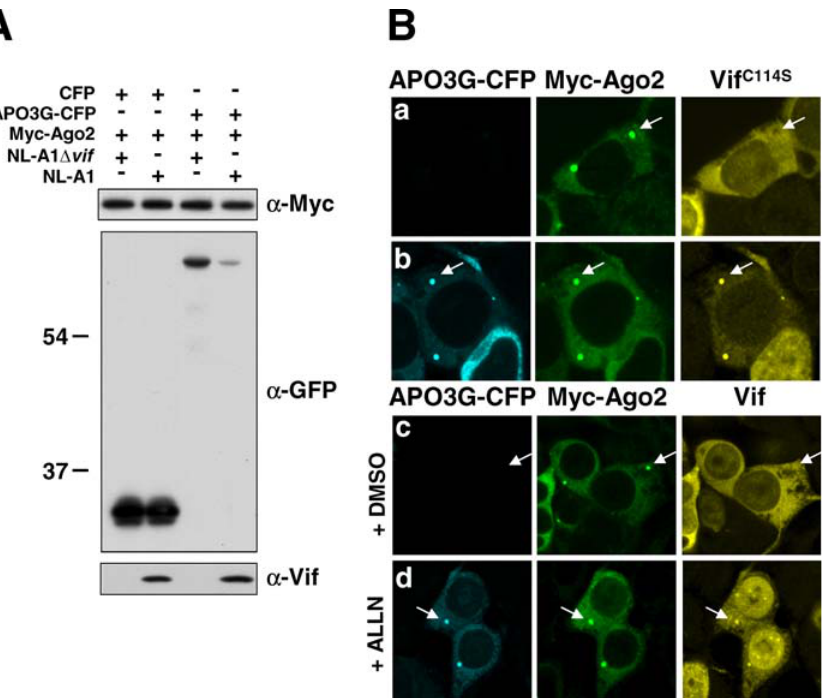
Figure 5. Localization of Vif to P-Bodies Requires APOBEC3G (A) Myc-AGO2 is not sensitive to Vif-mediated degradation in the absence or presence of APO3G-CFP. Total cell extracts from 293T cells expressing CFP or APO3G-CFP with Myc-AGO2 and either NL-A1 D vif or NL-A1 were analyzed by immunoblot with antibodies against CFP ( a -GFP), c-Myc ( a -Myc) and Vif ( a -Vif). Numbers to the left indicate molecular mass in kDa. (B) Subcellular localization images of 293T cells coexpressing a combination of Myc-AGO2 and Vif C114S (a), APO3G-CFP, Myc-AGO2, and Vif C114S (b), or APO3G-CFP, Myc-AGO2, and Vif following a 4-h incubation with the proteasome inhibition ALLN (d) or the equivalent DMSO vehicle control–treated cells (c). APO3G-CFP was detected by direct CFP fluorescence while Myc-AGO2 and Vif protein were detected by indirect immunostaining with antibodies against c-Myc and Vif, respectively. Arrows mark regions of colocalization or lack of colocalization between proteins. DOI: 10.1371/journal.ppat.0020041.g005